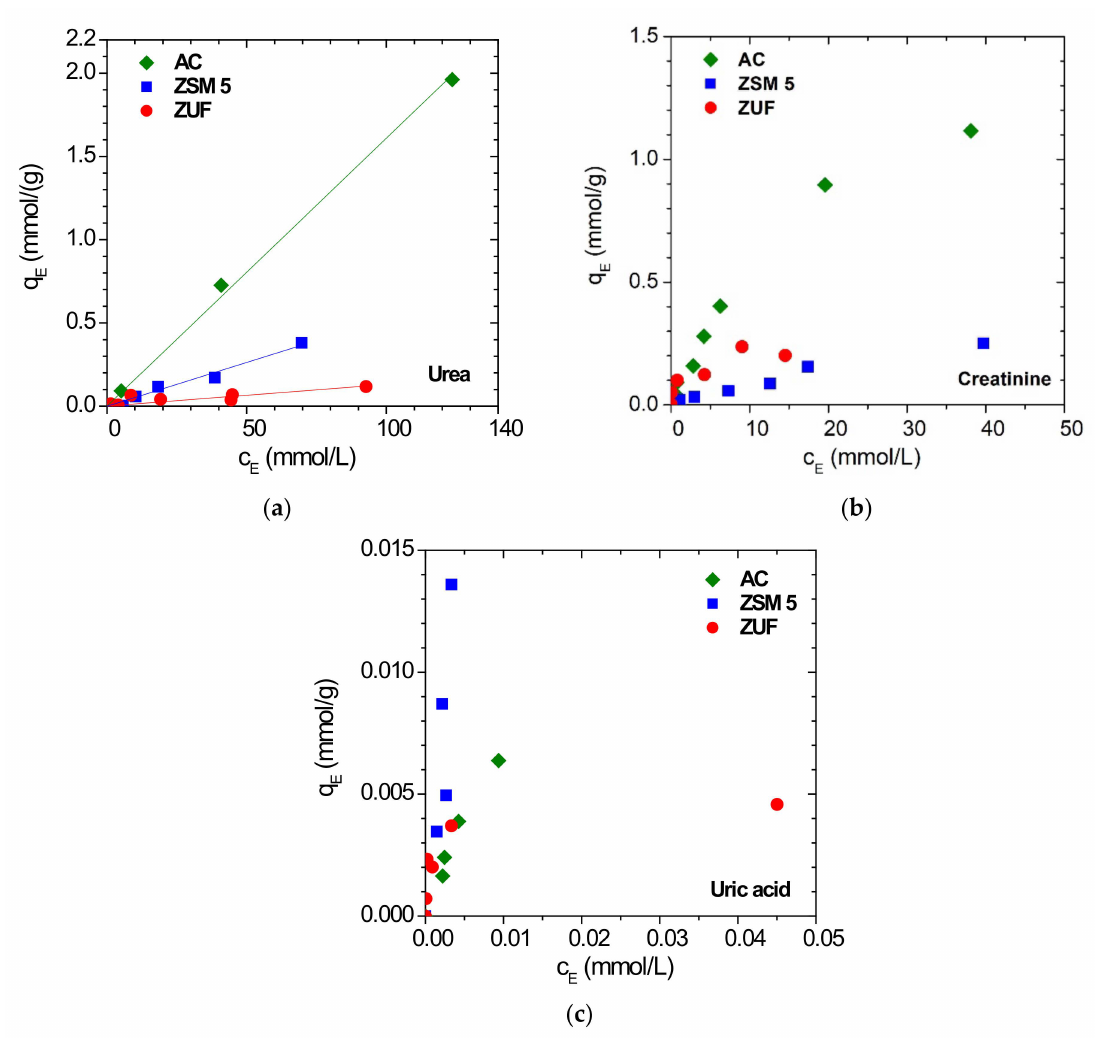
Figure 6. Static adsorption isotherms of ( a ) urea ( b ) creatinine ( c ) uric acid in the various fillers